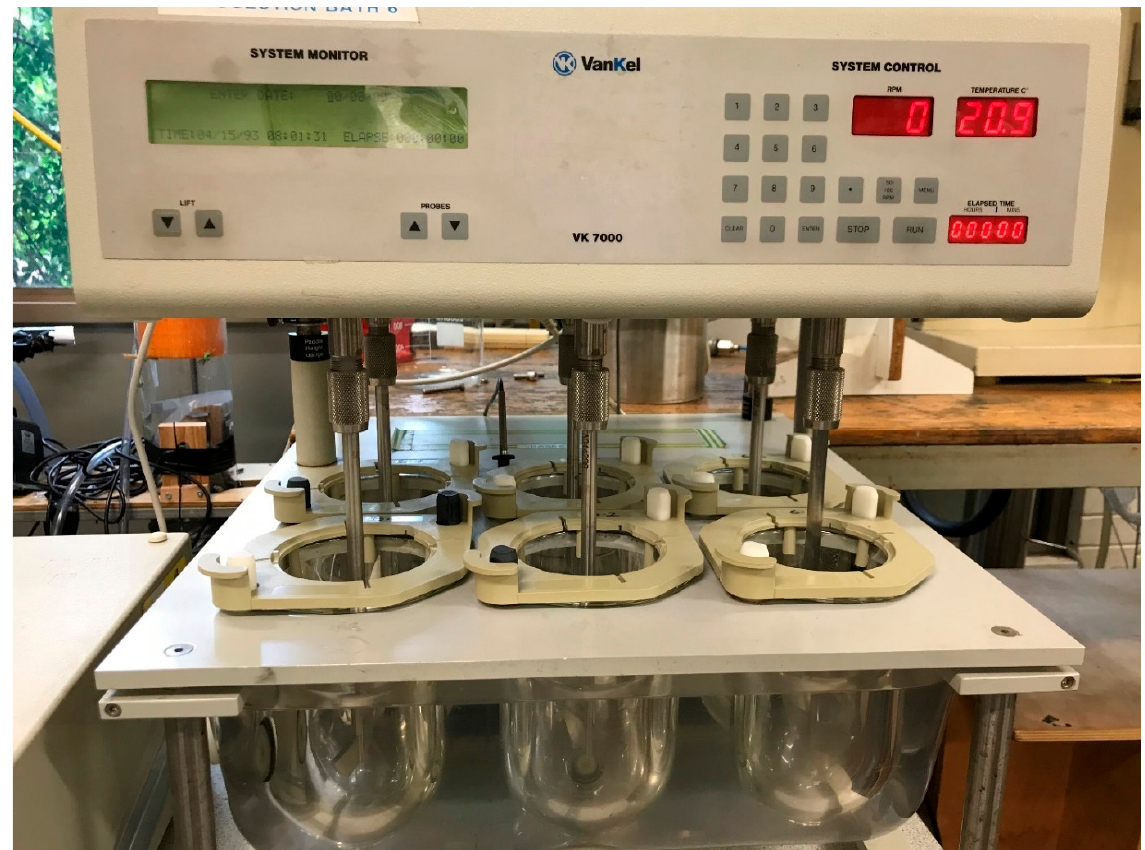
Figure 3. USP Dissolution Apparatus 2.